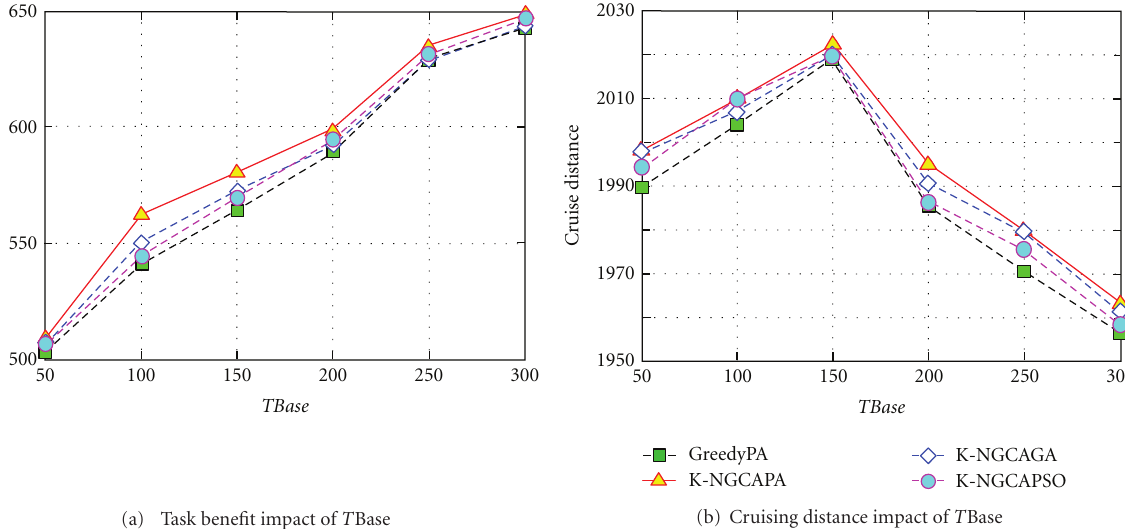
Figure 5: Scheduling results in various T Base.